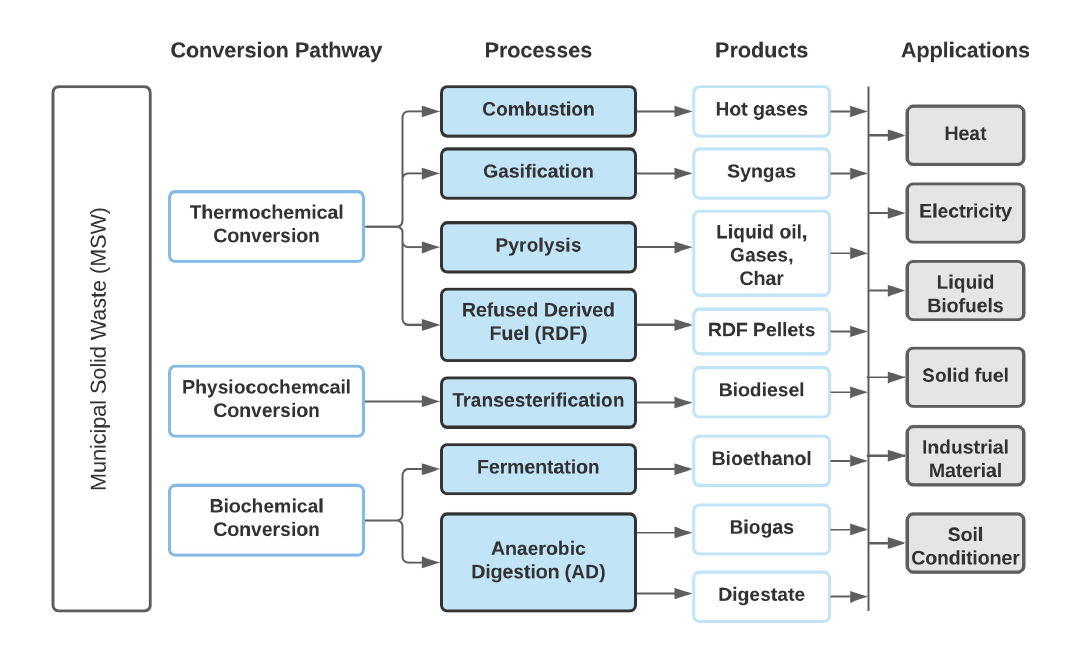
Figure 3. Waste-to-energy (WTE) technologies based on their conversion process.